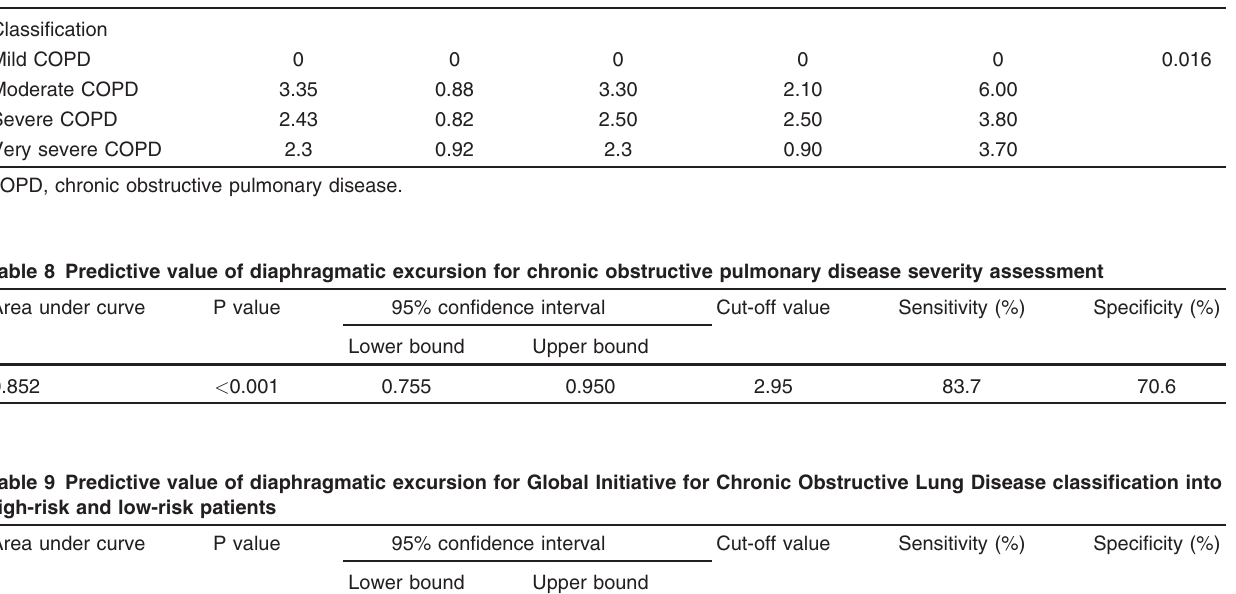
Table 7 Correlation between FEV1 classification of chronic obstructive pulmonary disease and diaphragmatic excursion